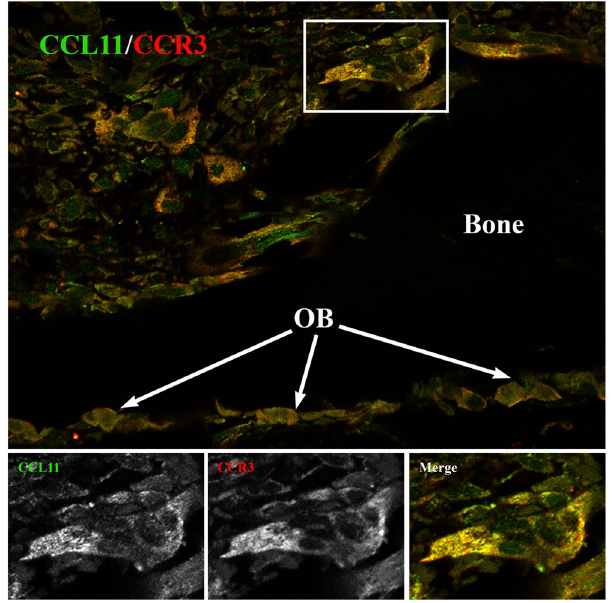
Figure 4. Co-localization of CCL11 and CCR3 receptor in osteoclasts of mouse parietal bones treated with PAM2. Representative immunofluorescence staining of parietal tissue section using CCL11 and CCR3 antibodies. Arrows point the layer of osteoblasts lining up on the bone surface (black). Lower panel demonstrates the higher magnification of squared osteoclast from image